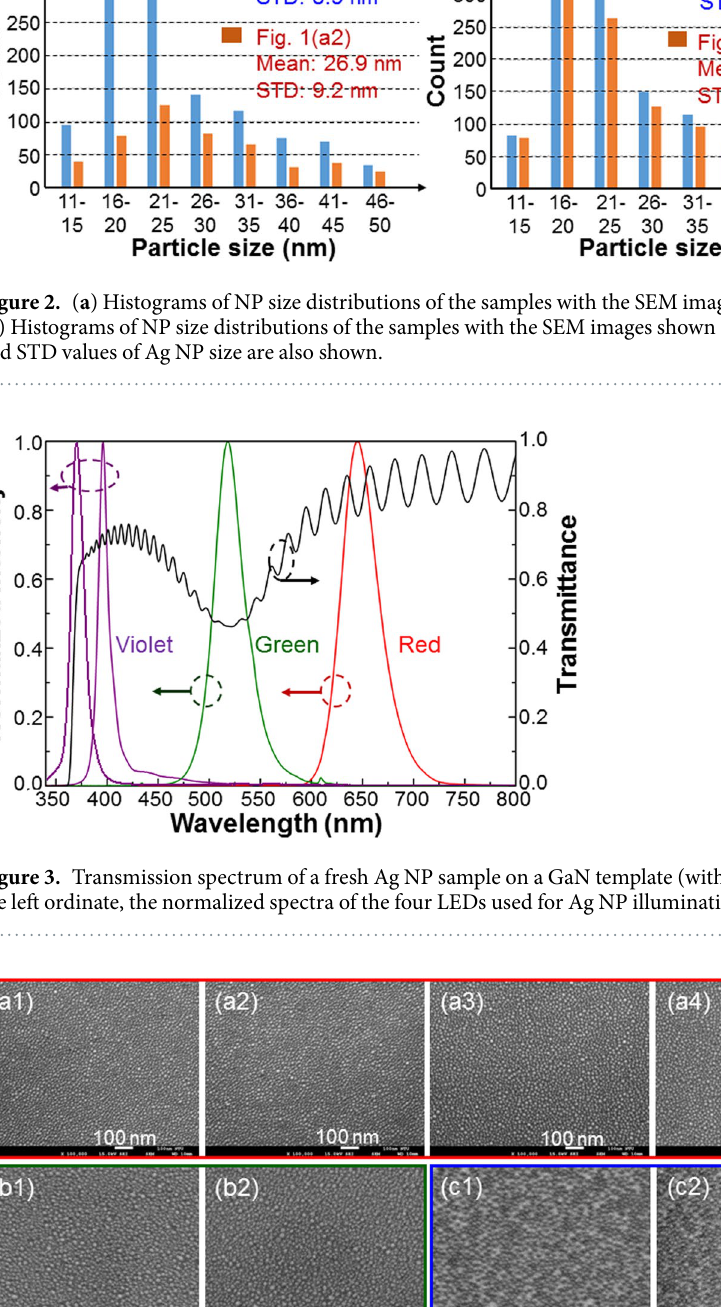
larger. To specify the effective illumination spectral range for causing NP aggregation, we illuminate fresh Ag NP samples with light-emitting diodes (LEDs) of designated wavelengths in a dark chamber under the atmospheric condition. With the right ordinate, Fig. 3 shows the transmission spectrum of a fresh Ag NP sample on a GaN